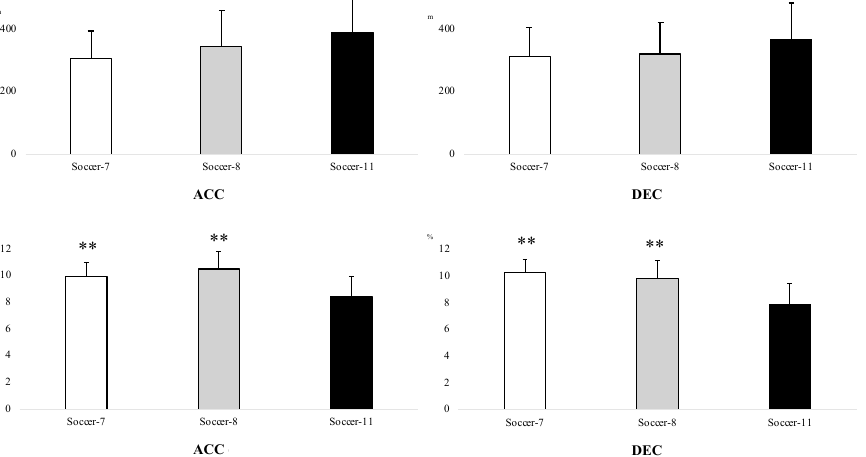
Figure 2. Absolute (m) and relative (%) distance covered in acceleration (ACC) and deceleration (DEC) during Soccer-7, Soccer-8, and Soccer-11 official matches among under-12 players. ES: Effect size. **: Significant difference versus Soccer-11 ( p < 0.01).